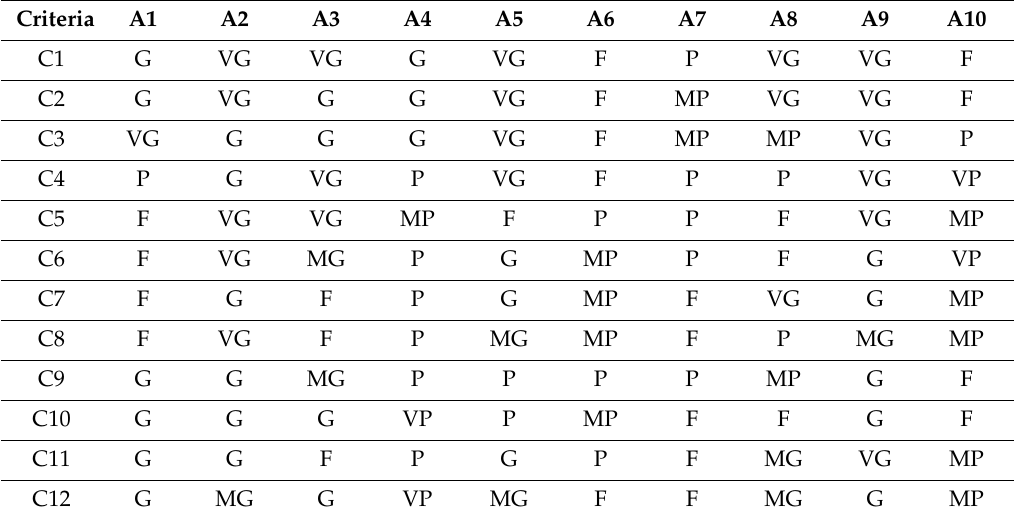
Table 7. Decision maker 2 (DM2) evaluates the alternatives.